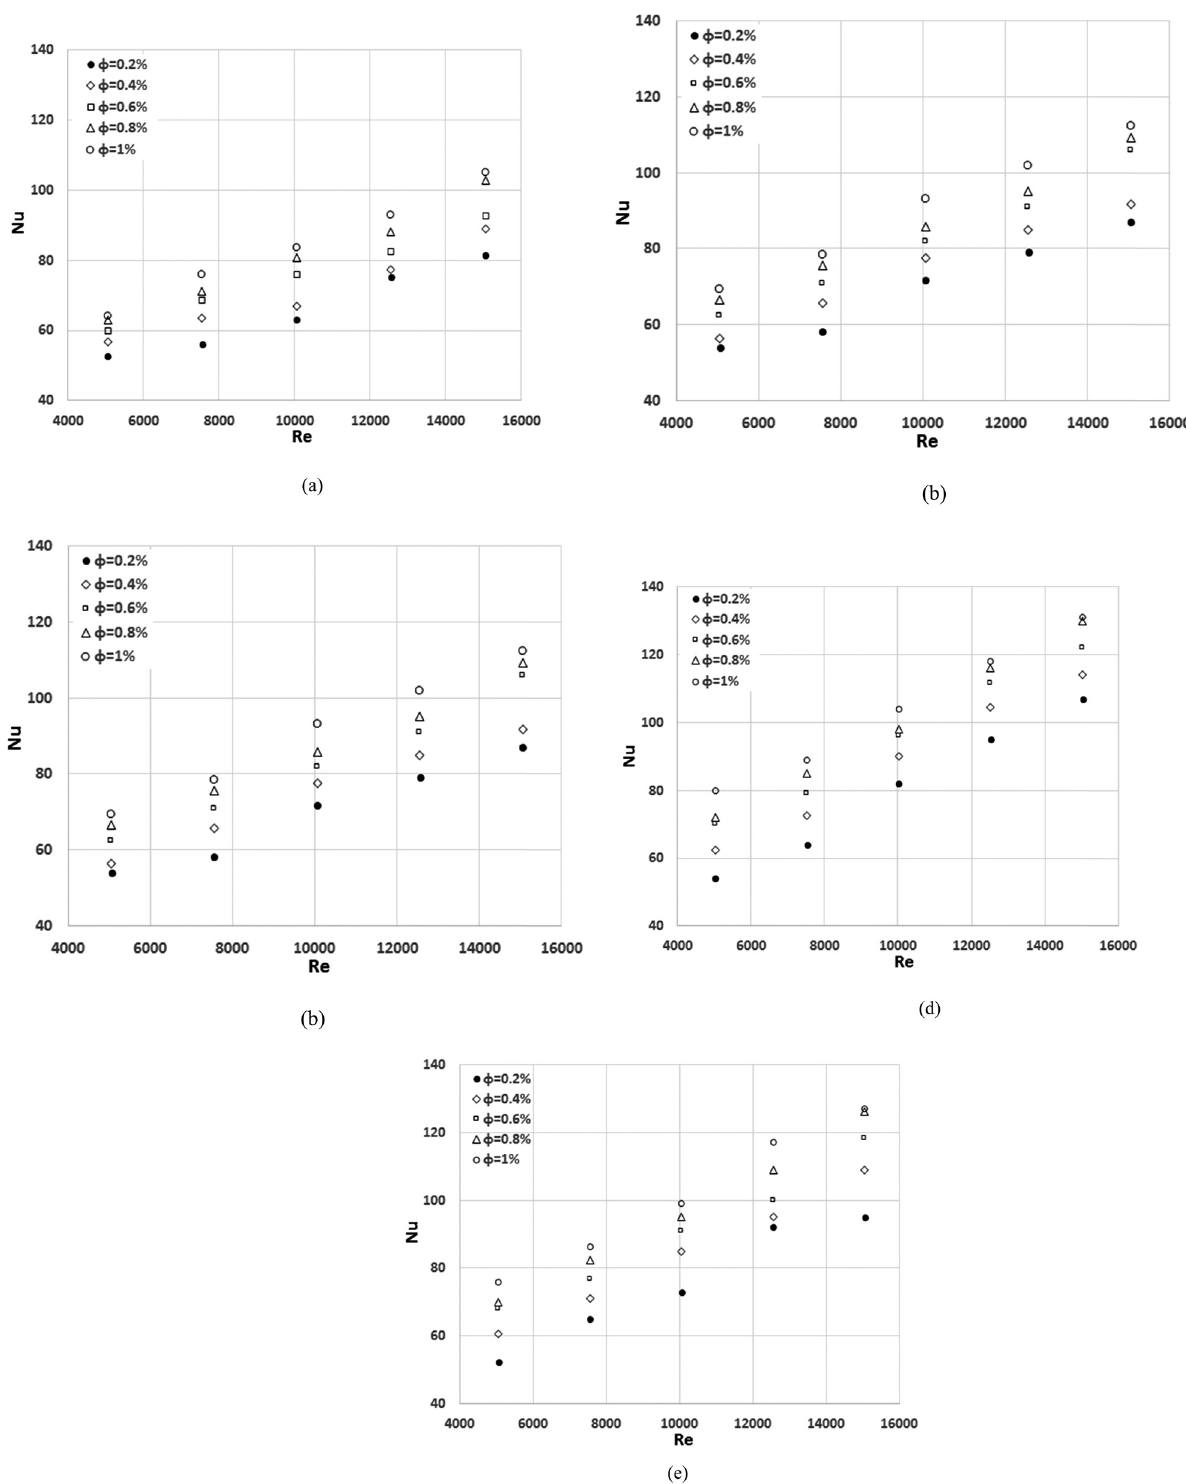
Figure 8: Nusselt number versus Reynold ’ s number at various CuO – Cu nanoparticle concentrations, with ( a ) H/D = 2, ( b ) H/D = 3, ( c ) H/D = 4, ( d ) H/D = 5, and ( e ) H/D =